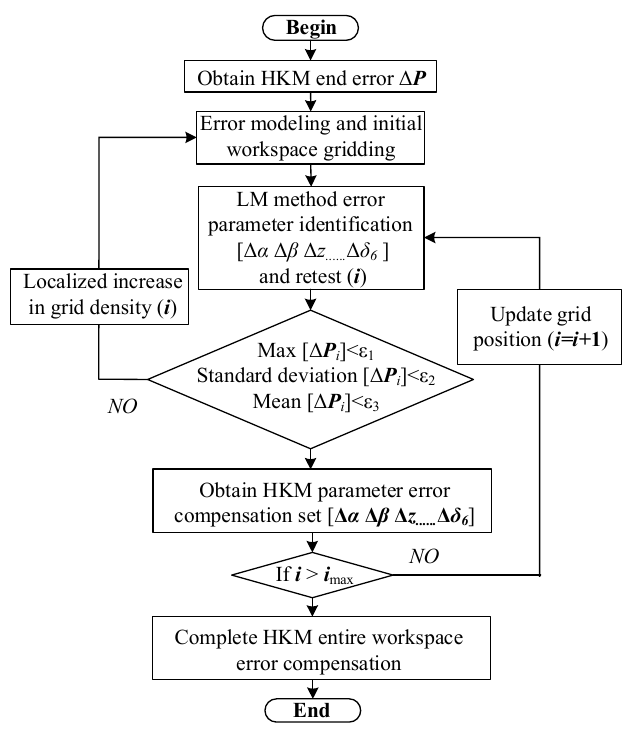
Figure 12. Flowchart of parameter error calculation within each grid.